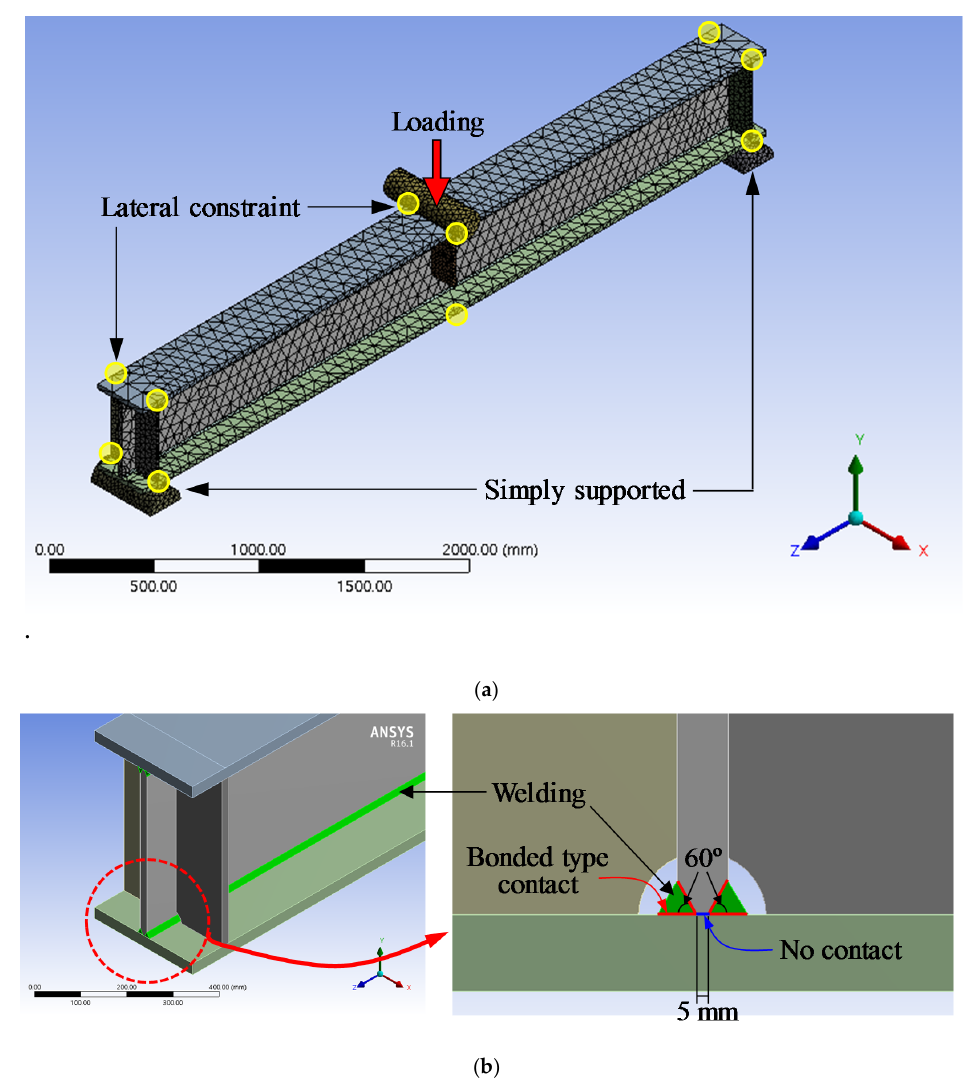
Figure 11. Finite element modelling. ( a ) Boundary condition; ( b ) welding part.